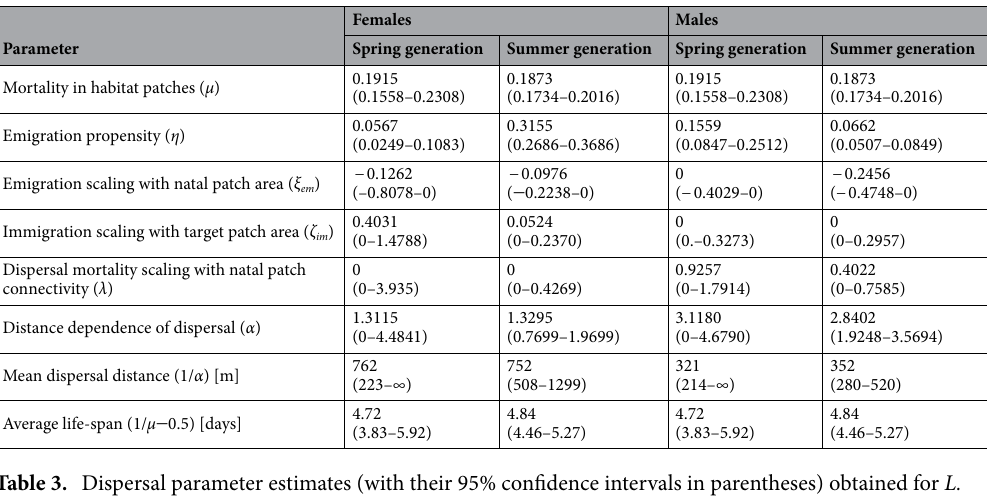
Table 3. Dispersal parameter estimates (with their 95% confidence intervals in parentheses) obtained for L. helle butterflies with the Virtual Migration model in 2019. Following the outcome of the Cormack-Jolly-Seber models, no inter-sexual difference in mortality in habitat patches, and consequently also in average adult life- span, was assumed (see the Methods section for details).